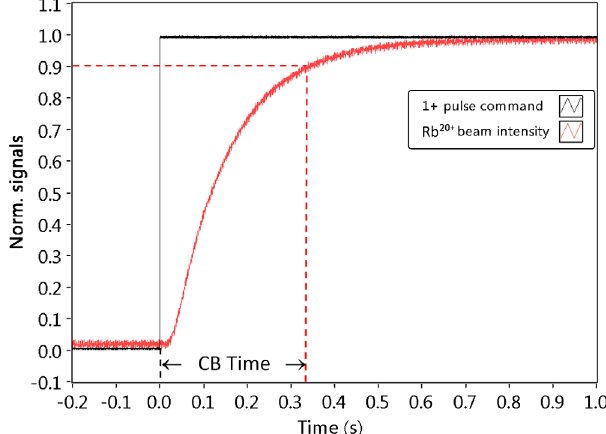
FIG. 1. Principle of the traditional τ lines are the references of the pulse start (black) and 90% level of the Rb 20 þ beam intensity